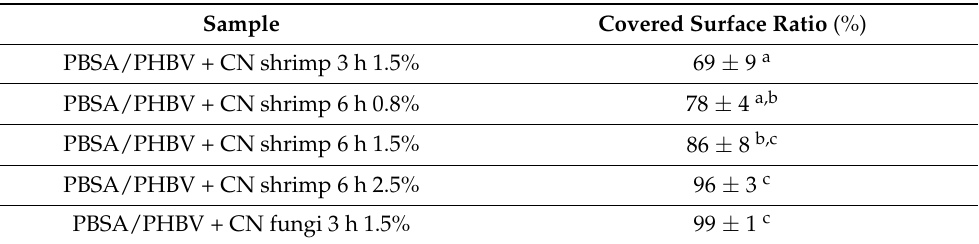
Table 6. Statistical analysis on Covered surface ratio results. The same letter means that values were not significantly different (confidence level 95%).